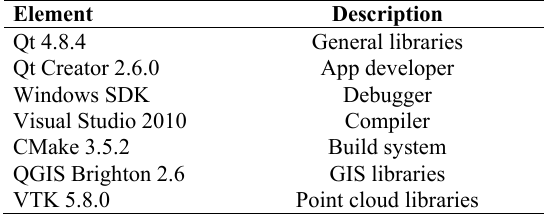
Table 2. Software and libraries